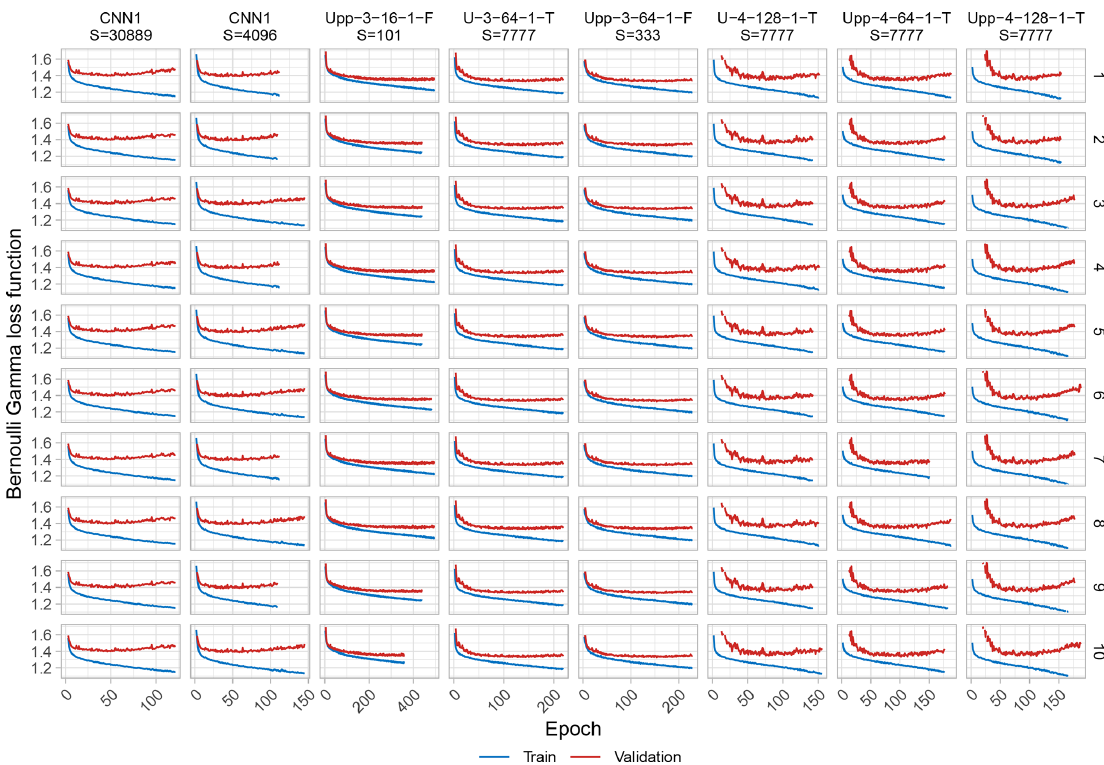
Figure A2. Training-validation loss plots for 10 runs under the same random seed number and configuration for the benchmark and a sub-selection of the transfer functions under non-deterministic conditions, ordered